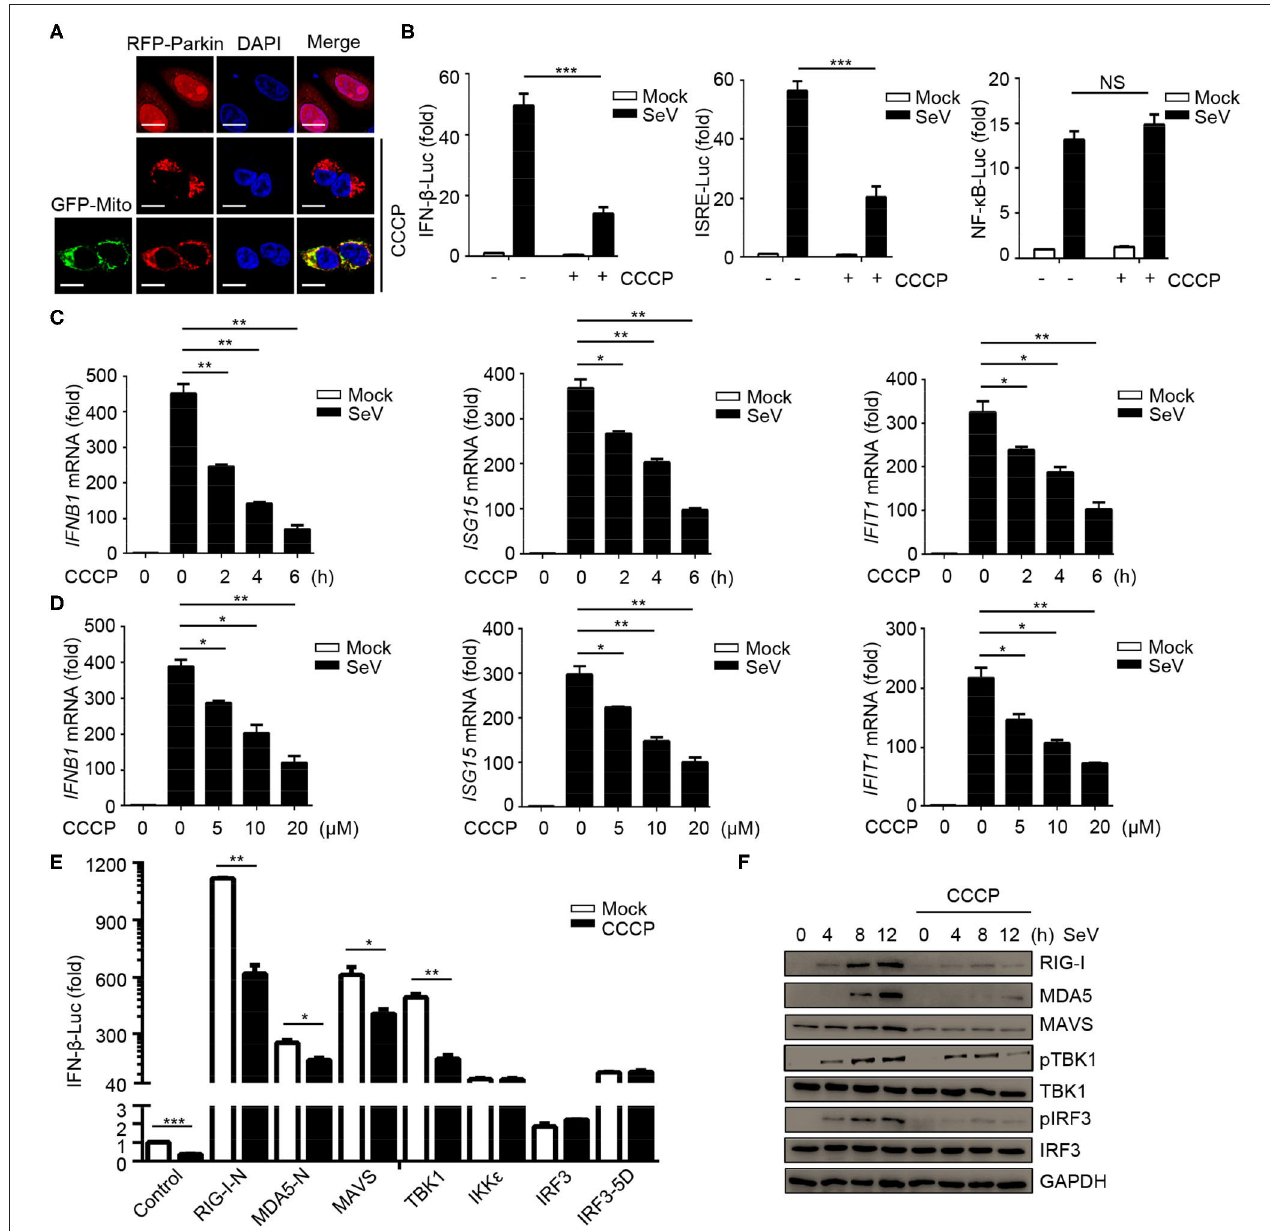
FIGURE 1 | Mitochondrial uncoupler CCCP inhibits type I IFN responses. (A) 293T cells were transfected with RFP-Parkin alone or together with GFP-Mito, 24h post-transfection, the cells were untreated or treated with CCCP (10 µ M) for 6h and subjected to IF analysis. Scale bar is 10 µ m. (B) HEK293 cells were transfected with a luciferase reporter of the IFN- β promoter, ISRE promoter, and NF- κ B promoter. 24h post-transfection, the cells were untreated or treated with CCCP (10 µ M) for 2h, then left unstimulated or stimulated with SeV for 10h, and luciferase assays were performed. (C) HEK293 cells were untreated or treated with CCCP (10 µ M) for different times, unstimulated or stimulated with SeV for 10h. Then quantitative RT-PCR analysis of IFNB1 , ISG15 , and IFIT1 mRNA. (D) HEK293 cells were untreated or treated with different concentrations of CCCP for 2h, then unstimulated or stimulated with SeV for 10h, and subjected to quantitative RT-PCR analysis. (E) HEK293 cells were co-transfected with IFN- β luciferase reporter and RIG-I-N, MDA5-N, MAVS, TBK1, IKK ε , IRF3, or IRF3-5D for 24h, then untreated or treated with CCCP (10 µ M) for 12h, and subjected to luciferase assays. (F) HEK293 cells were untreated or treated with CCCP (10 µ M) for 2h, then unstimulated or stimulated with SeV for different times, and the whole cell extracts were subjected to IB analysis. The data represent the average of three independent experiments and were analyzed by unpaired t- test. All data represent the mean ± S.D. * p < 0.05, ** p < 0.01, and *** p < 0.001.